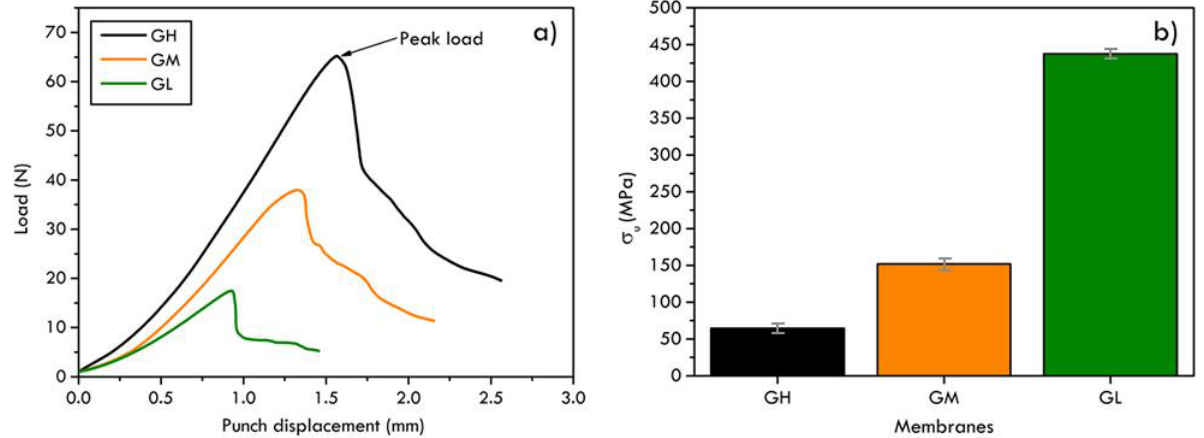
Figure 4 . Force – displacement curves ( a ) and estimated values of the tensile strength ( b ) of the three graphite foils with different thicknesses.